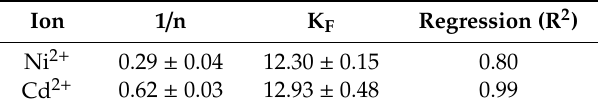
Table 7. Freundlich adsorption isotherm constants for Ni 2 + and Cd 2 + ions adsorbed onto hematite